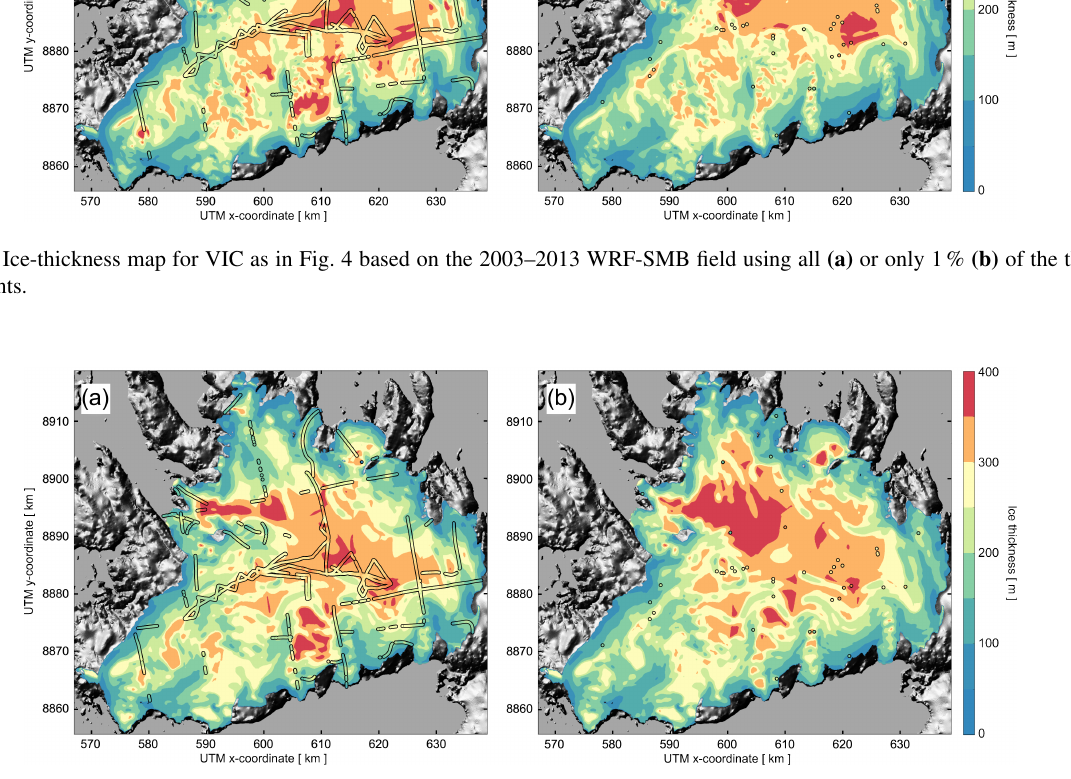
Figure C2. Ice-thickness map for VIC as in Fig. 4. Here, the reconstruction is conducted with the NPI 50m (http://publicdatasets.data.npolar. no/kartdata/NP_S0_DTM50.zip) as surface topography using either all (a) or only 1% (b) of the thickness